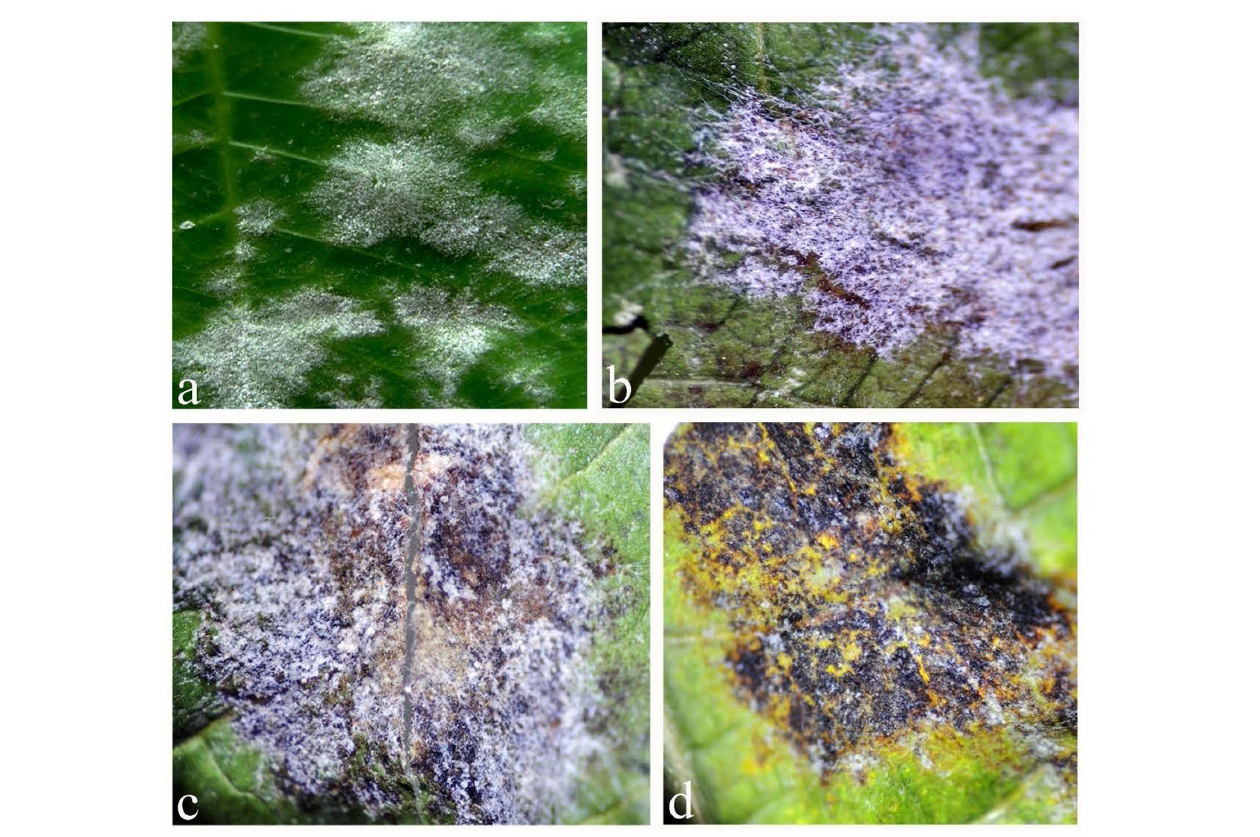
FIGURE 1 | Different stages of Ampelomyces spp. infection of powdery mildew fungal colonies: (a) healthy colonies of powdery mildew on the surface of rubber leaf; (b) powdery mildew colonies infected with Ampelomyces spp. (the brown color spots are the pycnidia produced by Ampelomyces ); (c) powdery mildew colonies partially destroyed by Ampelomyces spp.; (d) . powdery mildew colonies totally destroyed by Ampelomyces, 1–2 weeks after